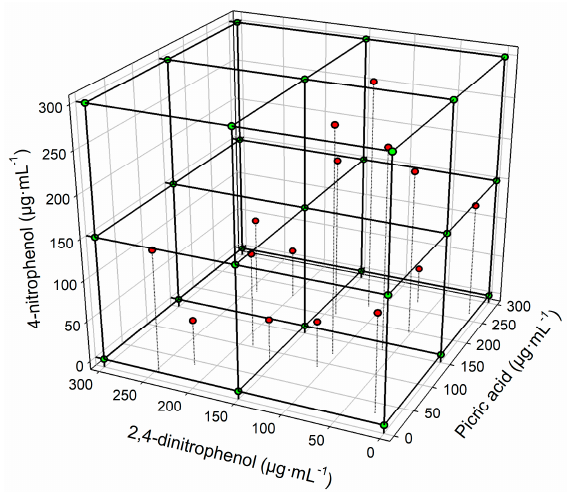
Figure 3. Representation of the full factorial experimental design employed, training samples ( ● , red circles), and test samples ( ● , green circles).